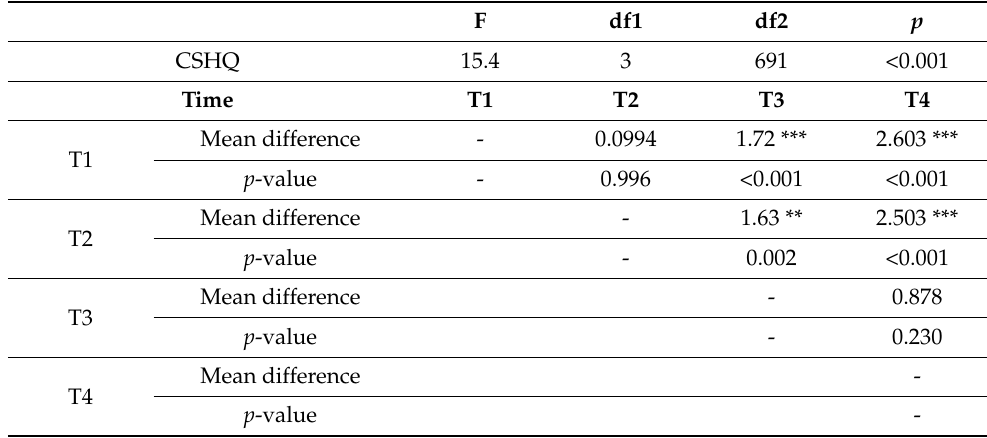
Table 3. One-Way ANOVA (Welch’s) and Games-Howell post hoc test of CSHQ score.